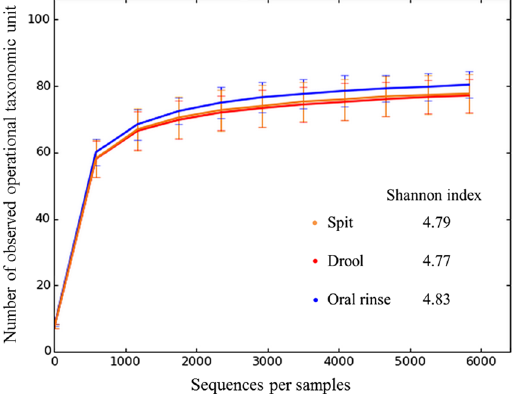
Figure 5. Rarefaction curve for observed operational taxonomic units against sequences per sample for spit, drool and oral